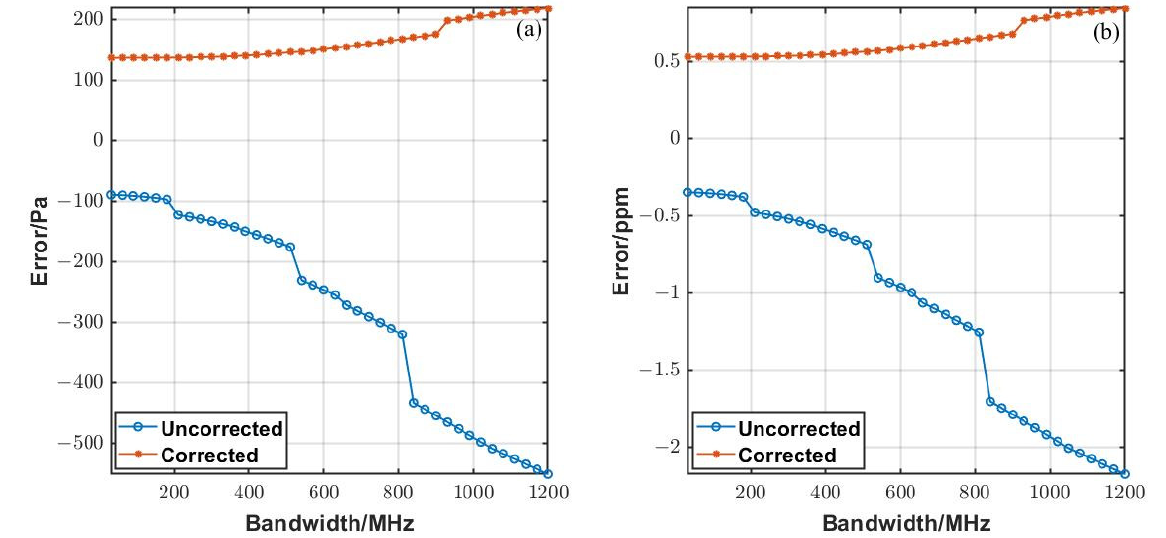
Figure 5. ( a ) Influence of wavelength shift on pressure error at different bandwidths. ( b ) Influence of wavelength shift on equivalent XCO 2 error at different bandwidths.